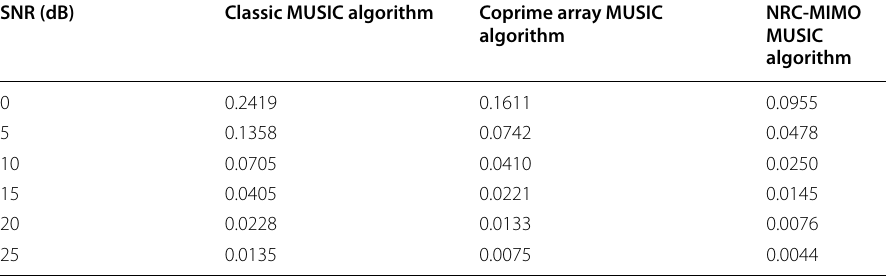
Table 3 RMSE value under different